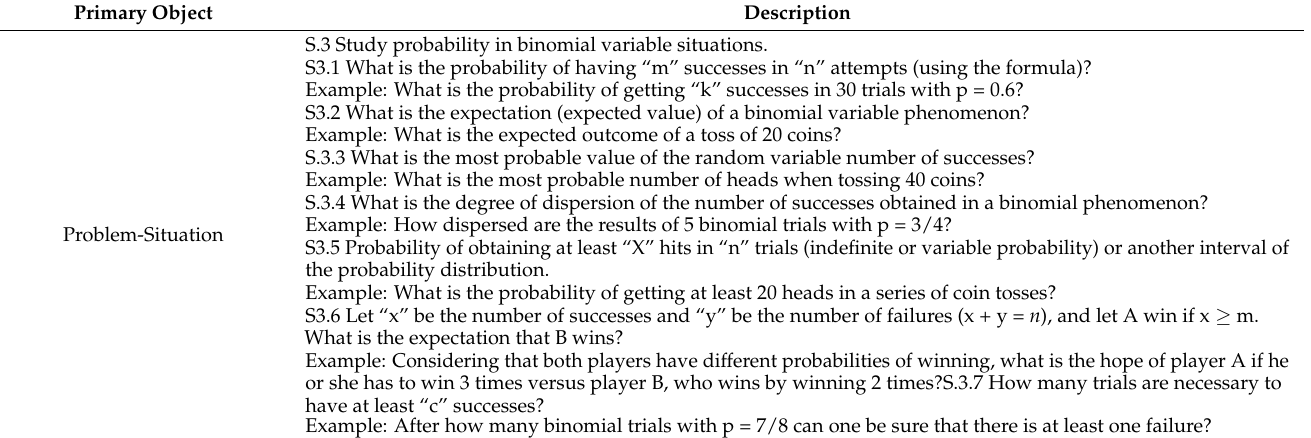
Table 14. Primary objects of the third meaning of the binomial